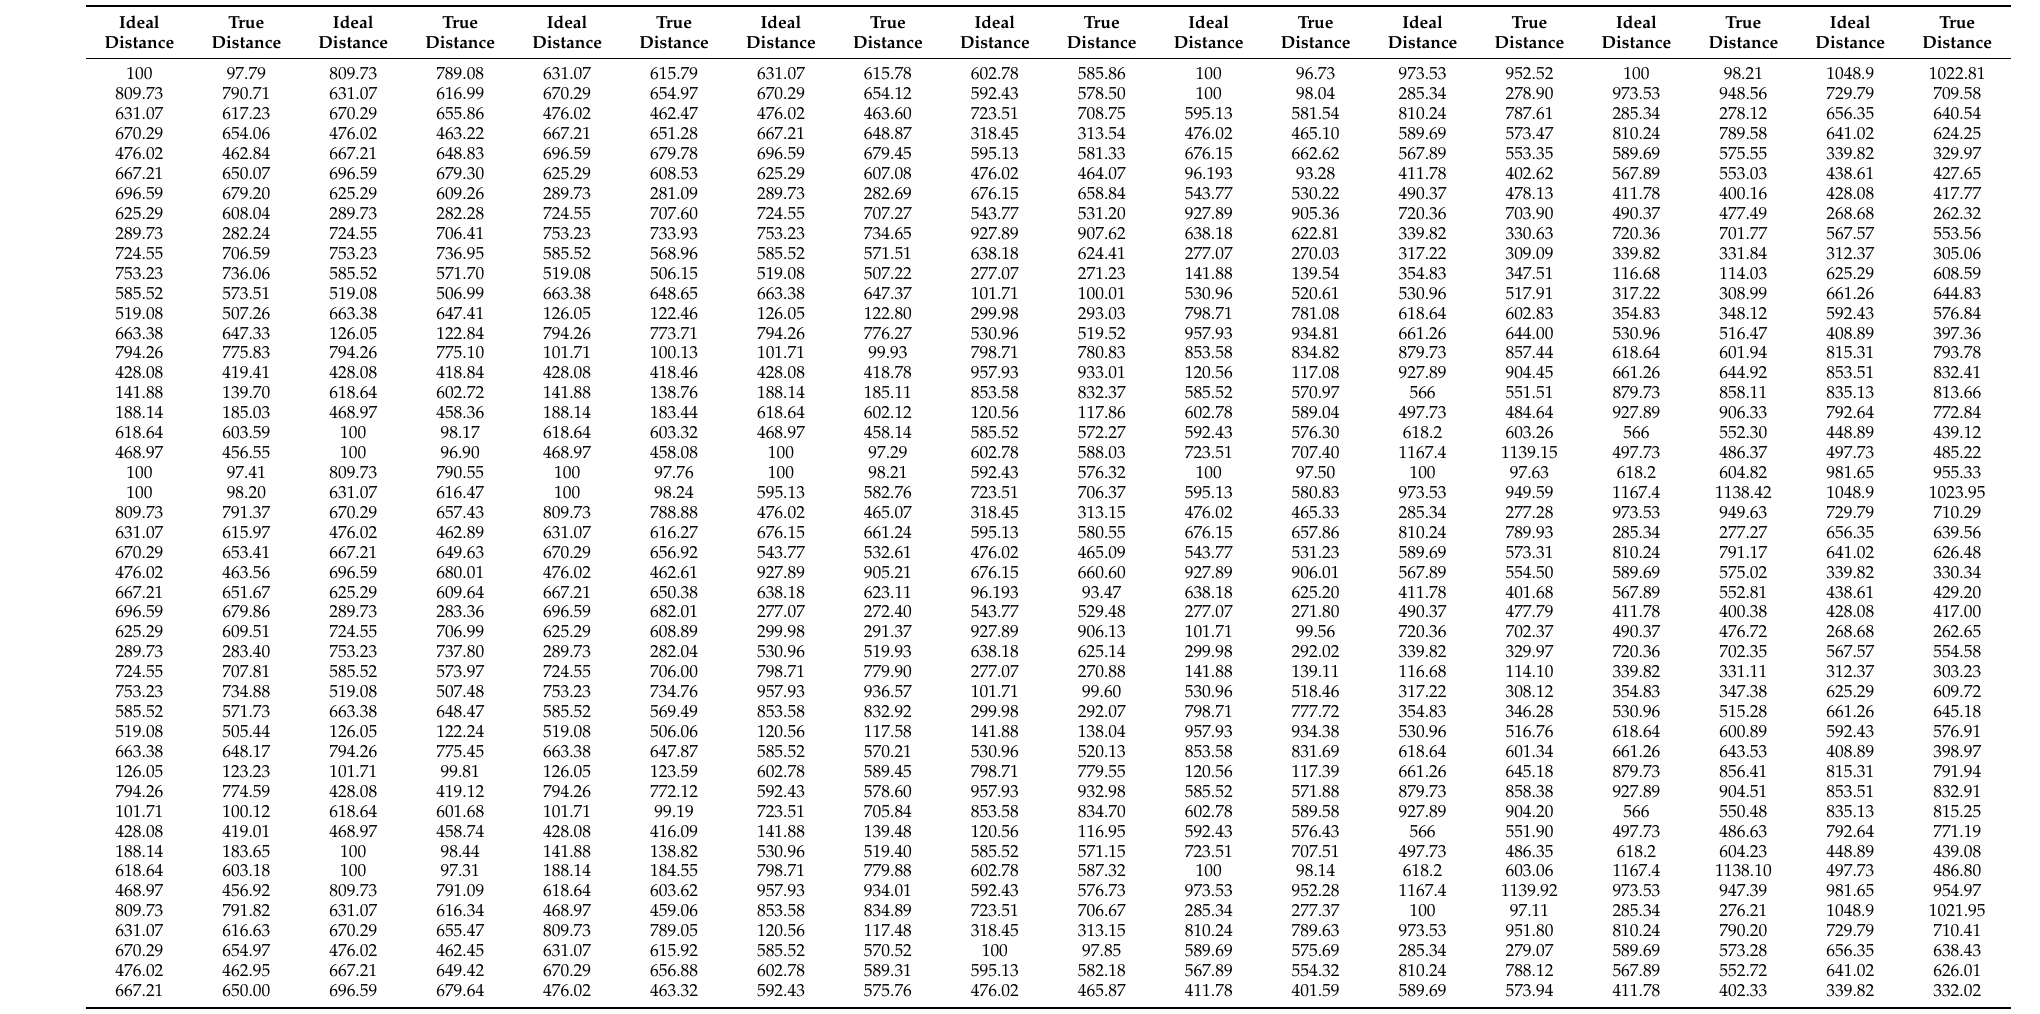
Table A2. Expected movement distances and actual movement distances